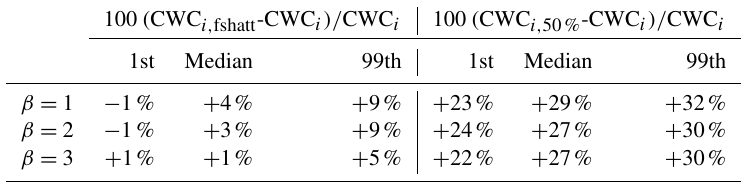
Table 3. Relative errors of retrieved CWC i, fshatt and CWC i, 50% with respect to CWC i in % for β = [1, 2,